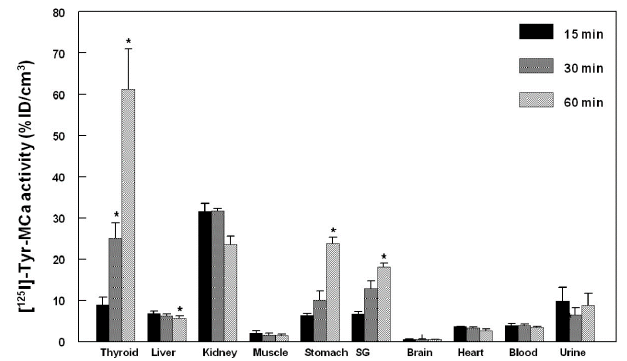
Figure 5. Quantification of in vivo tomographic images of 125 I-Tyr-MCa whole-body distribution at 15, 30, and 60 min post-injection. * p ≤ 0.05 versus 15 min.